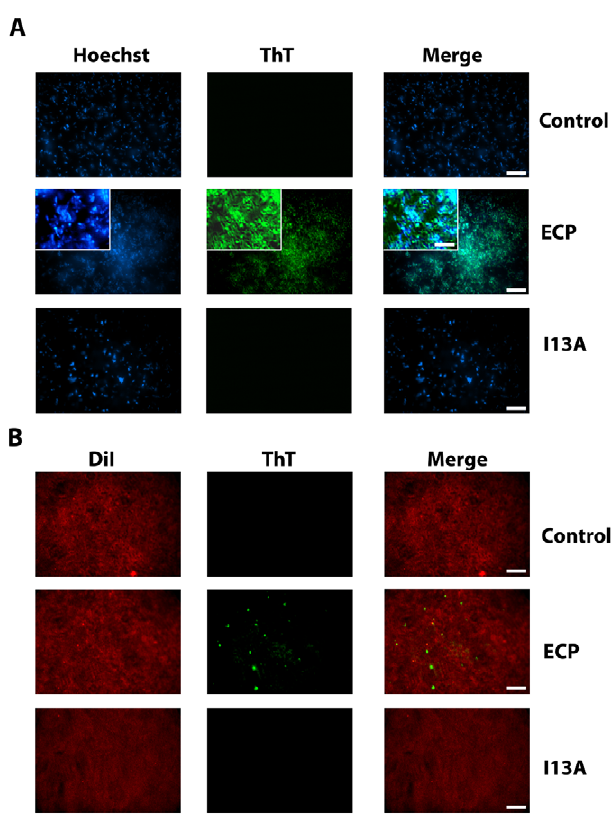
Figure 4. ECP but not I13A form amyloid-like aggregates on the surface of bacteria and membranes. (A) E. coli bacteria cells stained with Hoechst (blue signal) were incubated with unlabeled wtECP or I13A mutant for 4 h, stained with ThT (green signal) and visualized by TIRF microscopy. In all experiments cell cultures were grown at exponential phase (OD 600 =0.2) and incubated with proteins in 10 mM sodium phosphate buffer, 100 mM NaCl, pH 7.4. (B) Planar lipid bilayers prepared as described in the Materials and Methods section (stained with DiI; red signal) were incubated with 5 m M of either unlabeled wtECP or I13A mutant for 4 h, stained with 25 m M ThT (green signal) and visualized using a Olympus FluoView 1000 TIRF microscope. Scale bar represents 20 m m (5 m m in the insight caption). Images depicted are representative from two independent experiments.